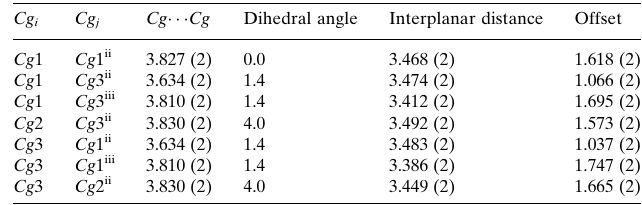
Table 2 (cid:2) – (cid:2) Interactions (A˚ , (cid:3)